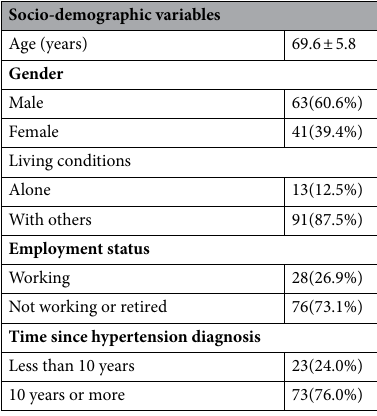
Table 5. Socio-demographic characteristics of the study sample. Data are mean ± standard deviation or